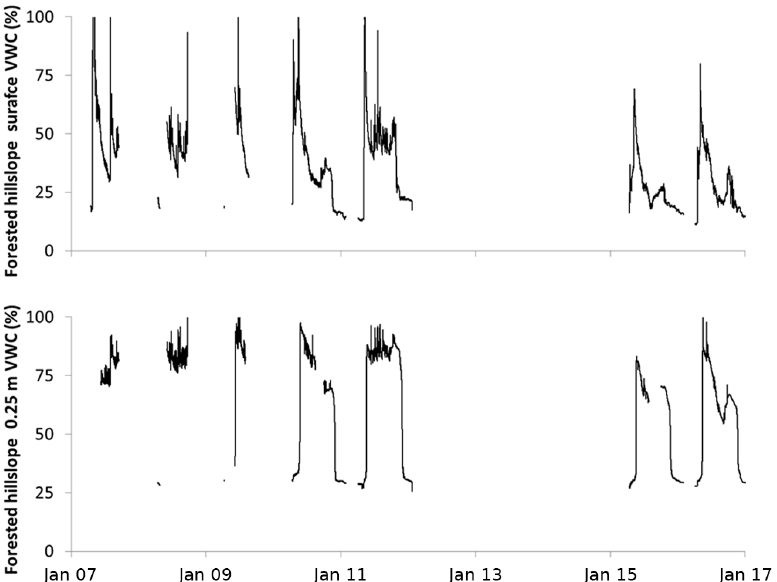
Figure 13. Half-hourly soil surface and 0.25m volumetric water content at the same forested hillslope soil moisture nest illustrated in Fig.